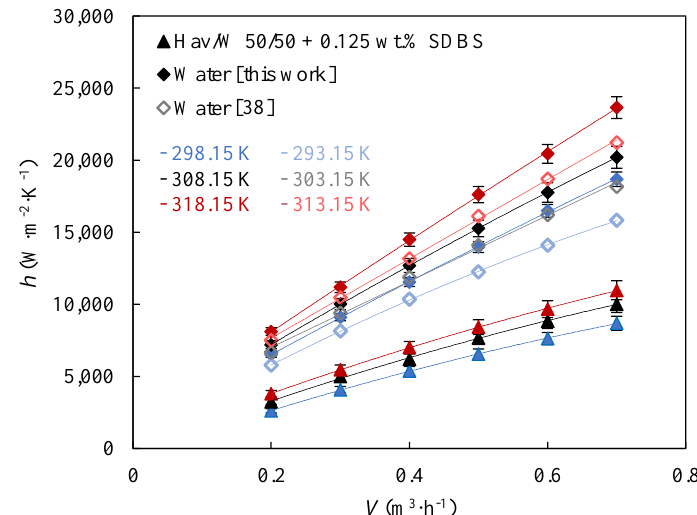
Figure 3. Experimental convection heat transfer coefficients, h , as a function of flow rate, V , for water and the base fluid at three temperatures. Error bars indicate the expanded uncertainty ( k = 2). Literature convection heat transfer coefficients for water [38] are shown for comparison.